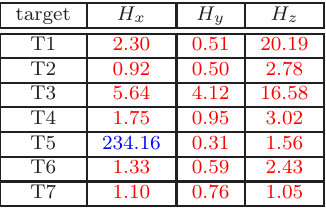
Table 4: values of H test